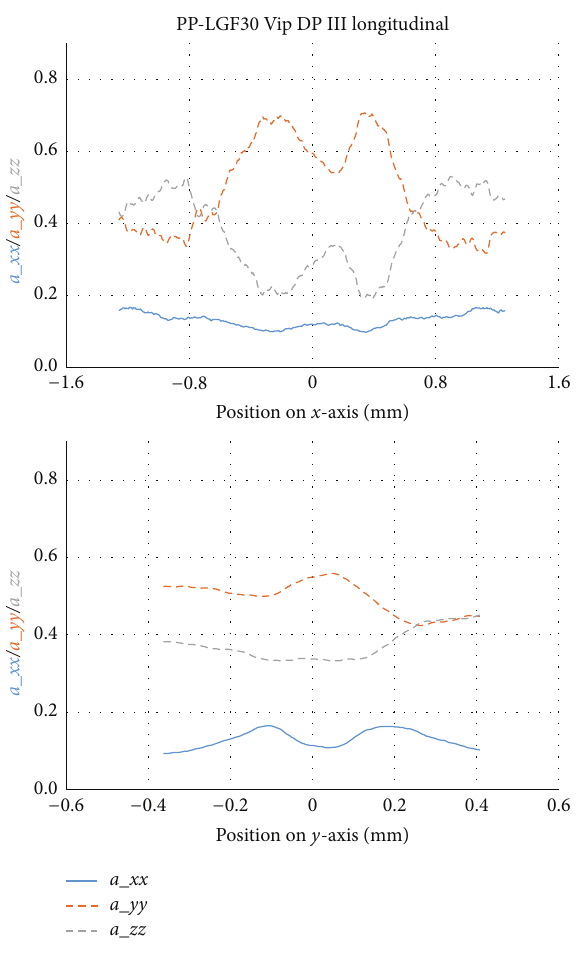
Figure 27: Progress of the fiber orientation along the 𝑥 - and 𝑦 -axis in the weld of two plates in vibration welding of PP-LGF30 with initial fiber orientation being transverse to the joining